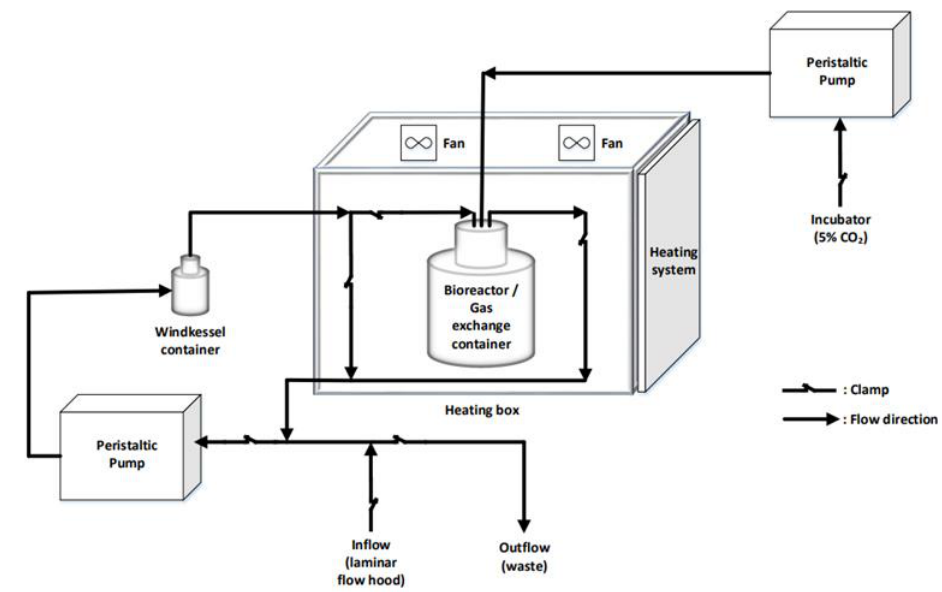
Figure 1. Conceptual view of the experimental setup of the bioreactor system to obtain dynamic cell culture.